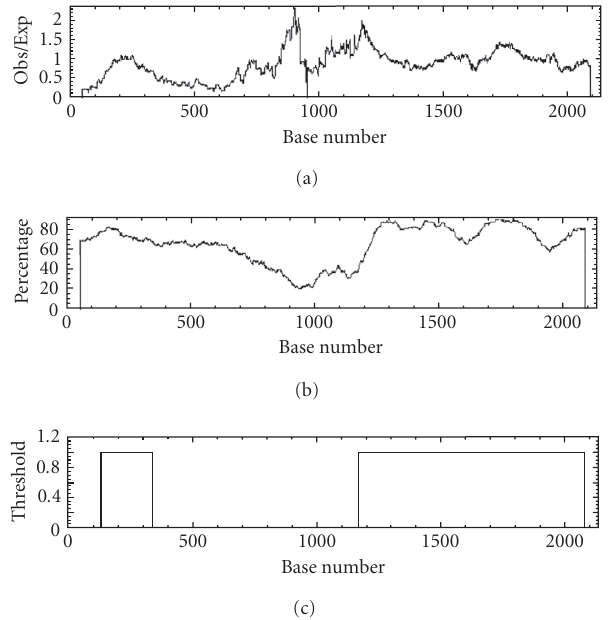
Figure 14: Graphs showing the results from the emboss CpGplot routine. (c) shows the predicted CpG islands (putative islands).